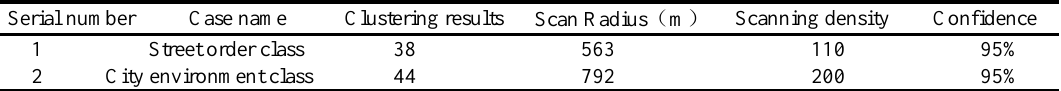
Table7. Statistical analysis of clustering results